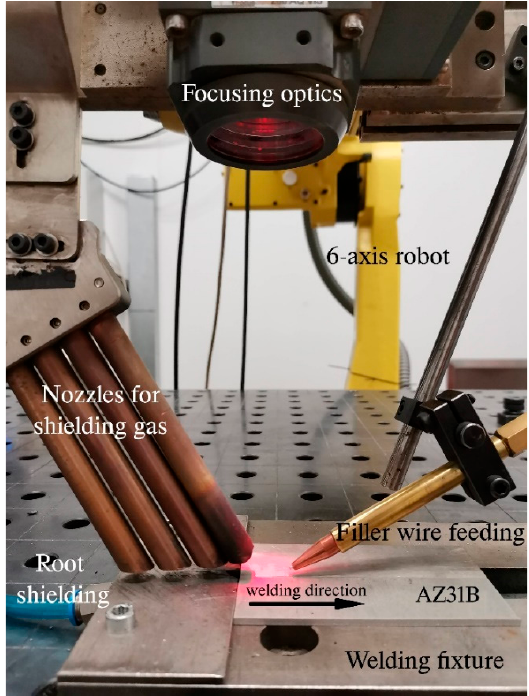
Figure 1. Experimental procedure scheme.